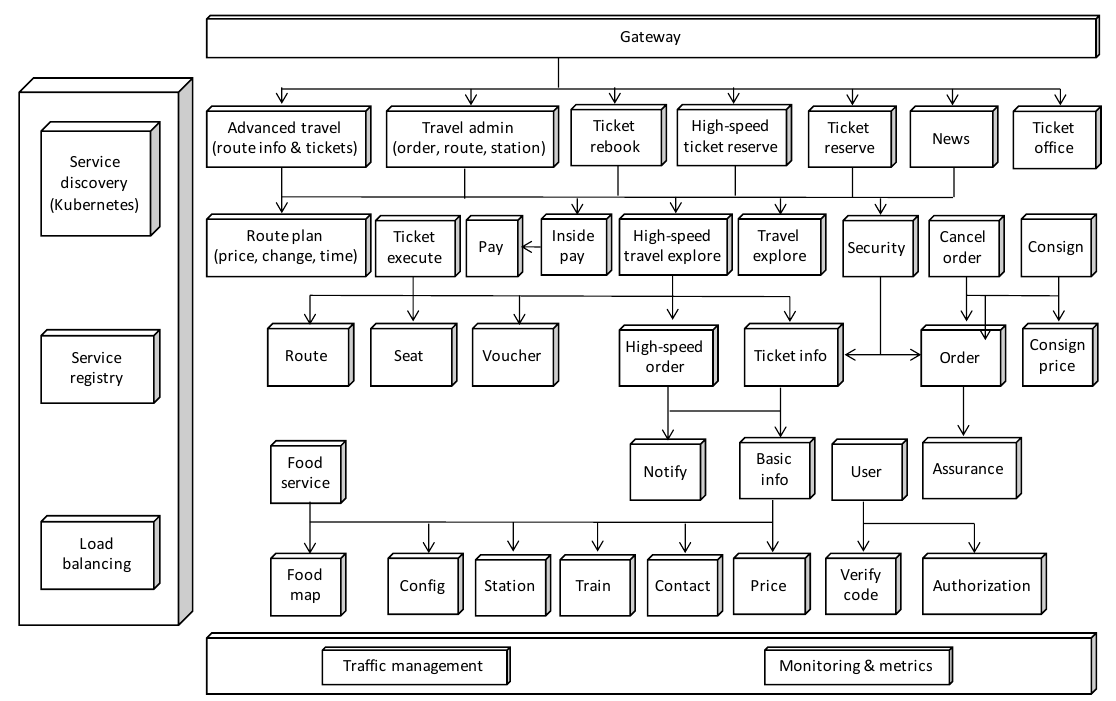
Figure 5. Train Ticket testbed architecture